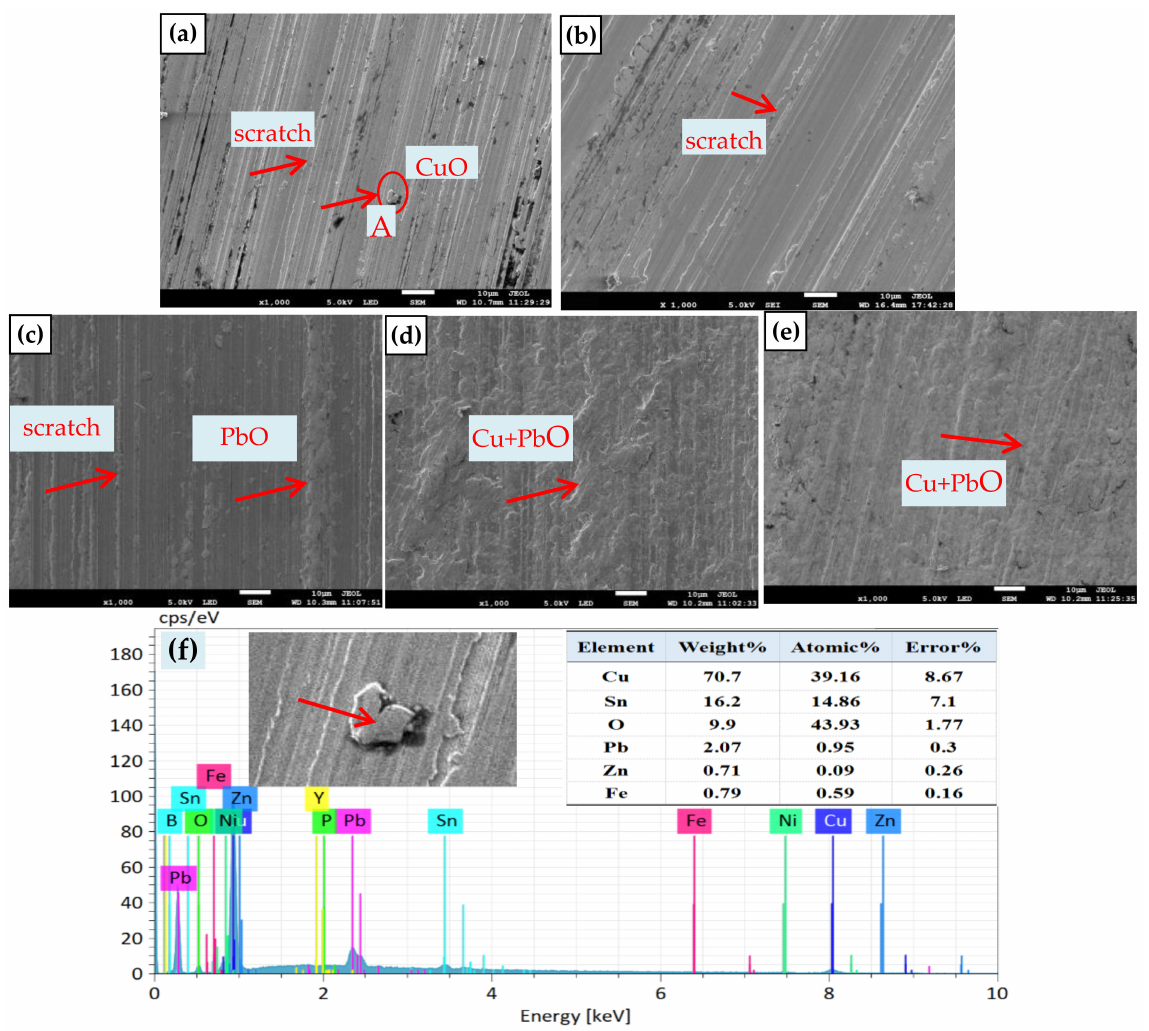
Figure 8. Analysis of friction topographies of 45 steel disks: ( a ) P = 0.0 wt.%, ( b ) P = 0.05 wt.%, ( c ) P = 0.1 wt.%, ( d ) P = 0.2 wt.%, ( e ) P = 0.3 wt.%, ( f ) EDS of